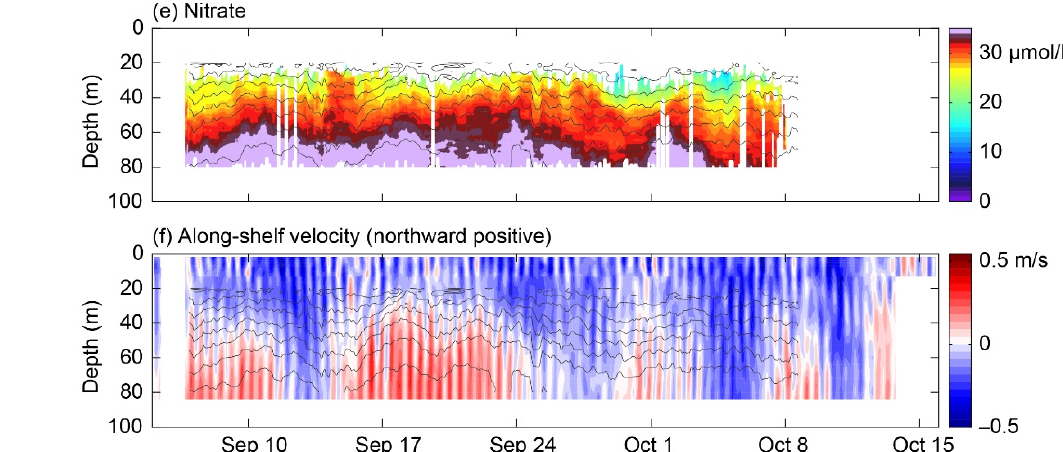
Figure 9. Biological and physico-chemical monitoring results from the ESP mooring and other platforms for the period 5 September to 15 October 2017. ( a ) 12-h smoothed near-surface (4 m) wind velocity vectors from the NDBC Cape Elizabeth buoy (46041), with the along-shelf direction (~345°T/165°T) aligned with the vertical axis. ( b ) Two independent measurements of chlorophyll- a concentrations at 1-m depth on the Cháb ă mooring (gray and black lines). Note the different scale on the vertical axes in panel b compared to Figure 7. VIIRS chlorophyll- a concentrations at the NEMO location are shown as magenta circles, with filled circles showing the times of satellite images shown in Figure 10. The concentration of particulate domoic acid (DA) in seawater and total abundance of Pseudo-nitzschia spp. quantified during the deployment ( P. australis , P. fraudulenta , P. multiseries , and P. pungens ) are shown as red asterisks and blue stars, respectively. Depth-time maps of ( c ) temperature, ( d ) dissolved oxygen concentration, ( e ) nitrate concentration, and ( f ) along-shelf velocity, with salinity contours overplotted on each, as recorded by the NEMO-SS and Cháb ă moorings. Times are in Pacific Daylight Time (UTC-7) for all panels.